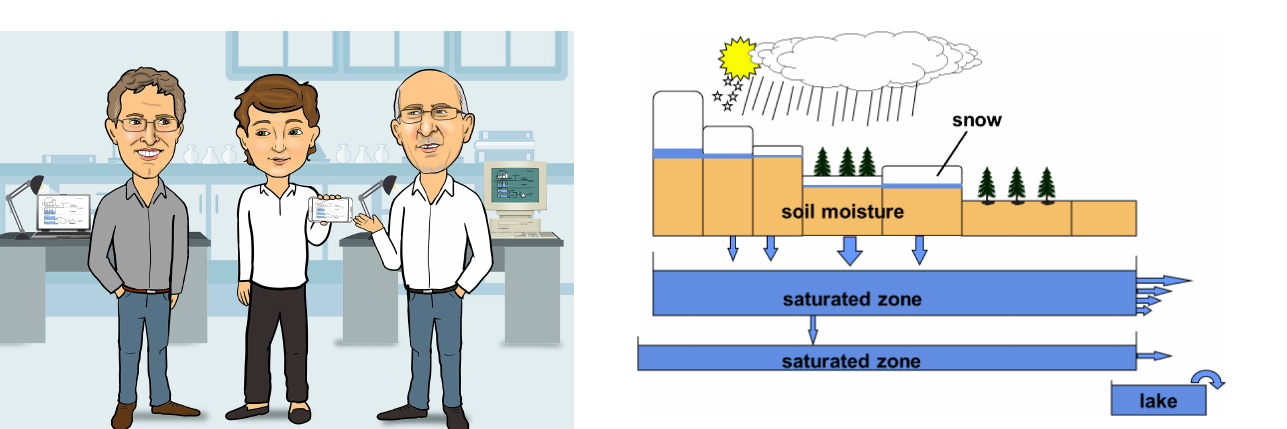
Figure 2. Structure of the HBV model (drawn by Sten